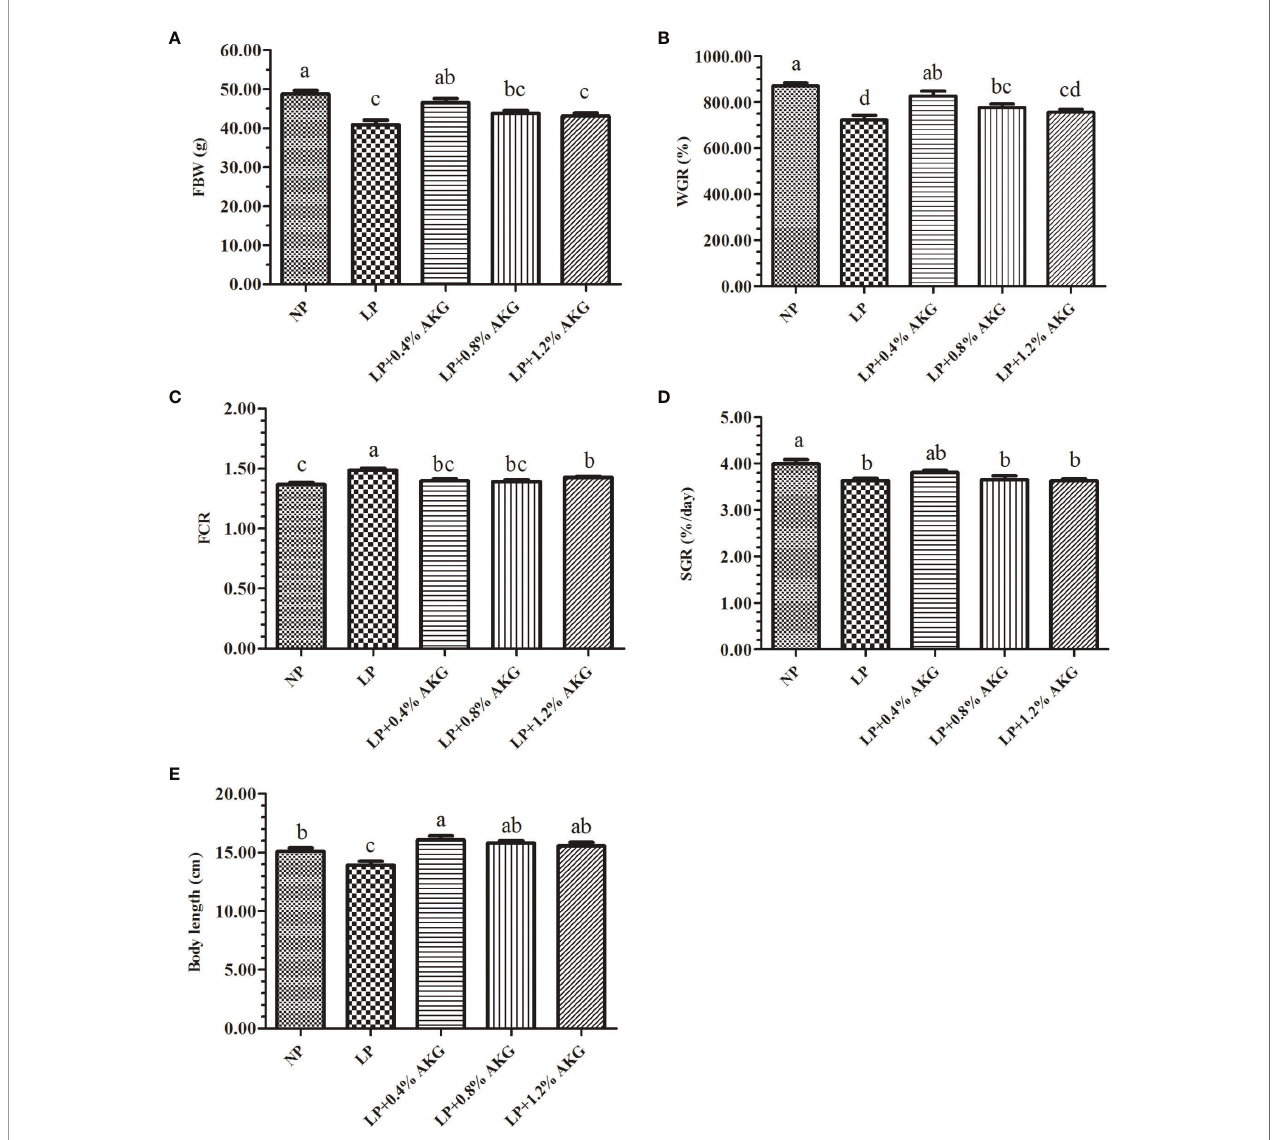
FIGURE 1 | Growth performance of common carp ( Cyprinus carpio ) fed with diets containing normal protein (NP), low protein (LP), and different concentrations of alpha-ketoglutarate (AKG) after 8 weeks. (A) FBW, fi nal body weight (g); (B) WGR, weight gain rate (%); (C) FCR, feed conversion ratio; (D) SGR, speci fi c growth rate (%/day); (E) Body length (cm). The initial body weight of common carp was 5.00 ± 0.74 g. Values are expressed as the mean ± SEM (n = 4). Values marked with different letters indicate signi fi cant differences ( P < 0.05) between groups.